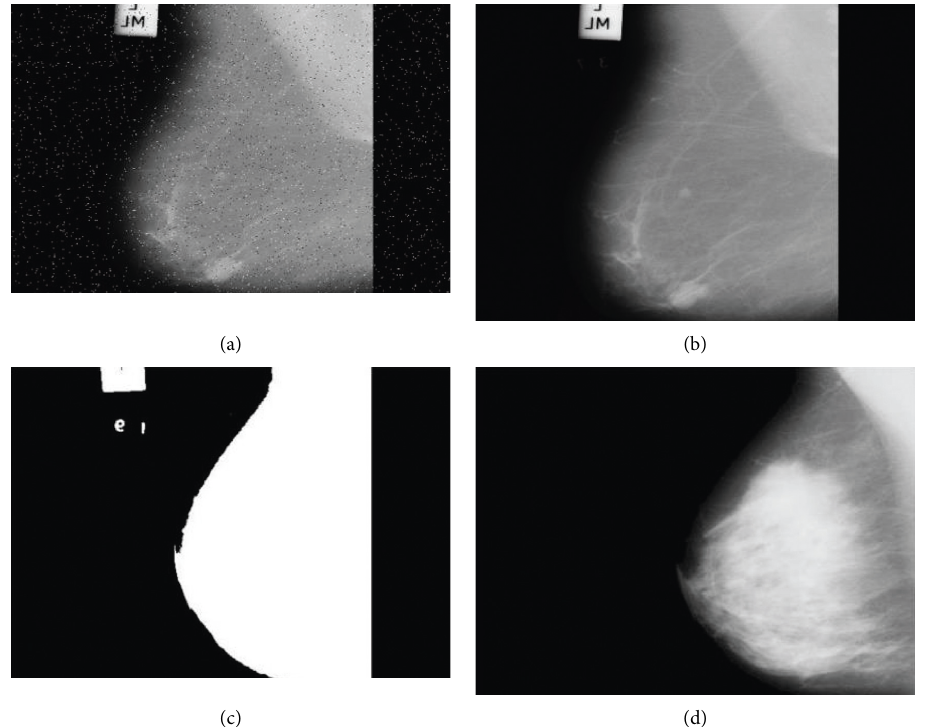
Figure 2: The preprocessing experiments of the input image. (a) The original image with noise. (b) Image after removing the noise. (c) The binary image after background separation. (d) The output image, the breast profile only.